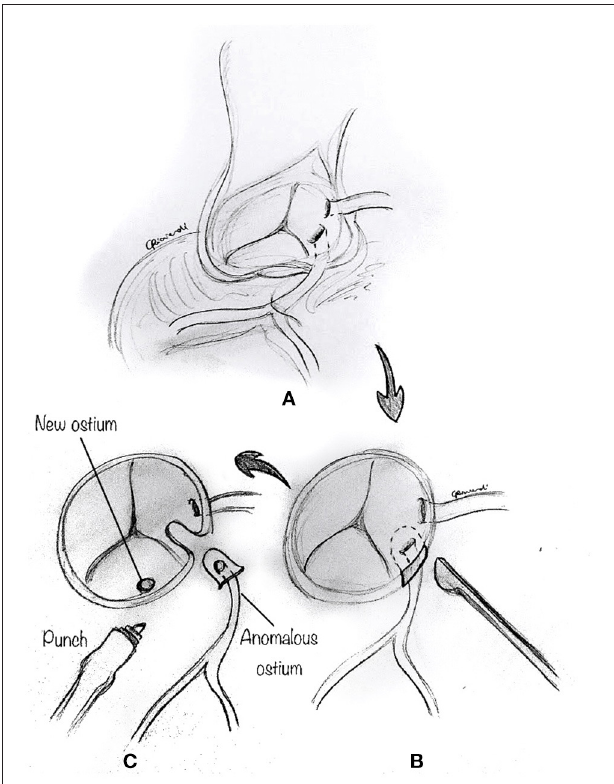
FIGURE 7 | Reimplantation technique. (A) The aberrant coronary artery is identified, dissected free along its course, and mobilized by means of low cautery. (B) A button of tissue around the ostium of the coronary artery is excised. Attention must be paid to avoid damage to the other coronary ostium, which may be very close. (C) A corresponding portion of the correct sinus is then incised with an aortic